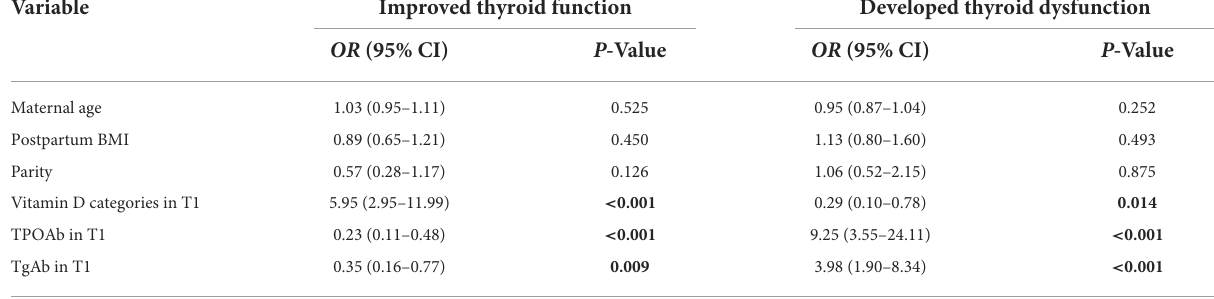
TABLE 3 Multivariate logistic regression analysis of factors affecting postpartum thyroid function. Variable